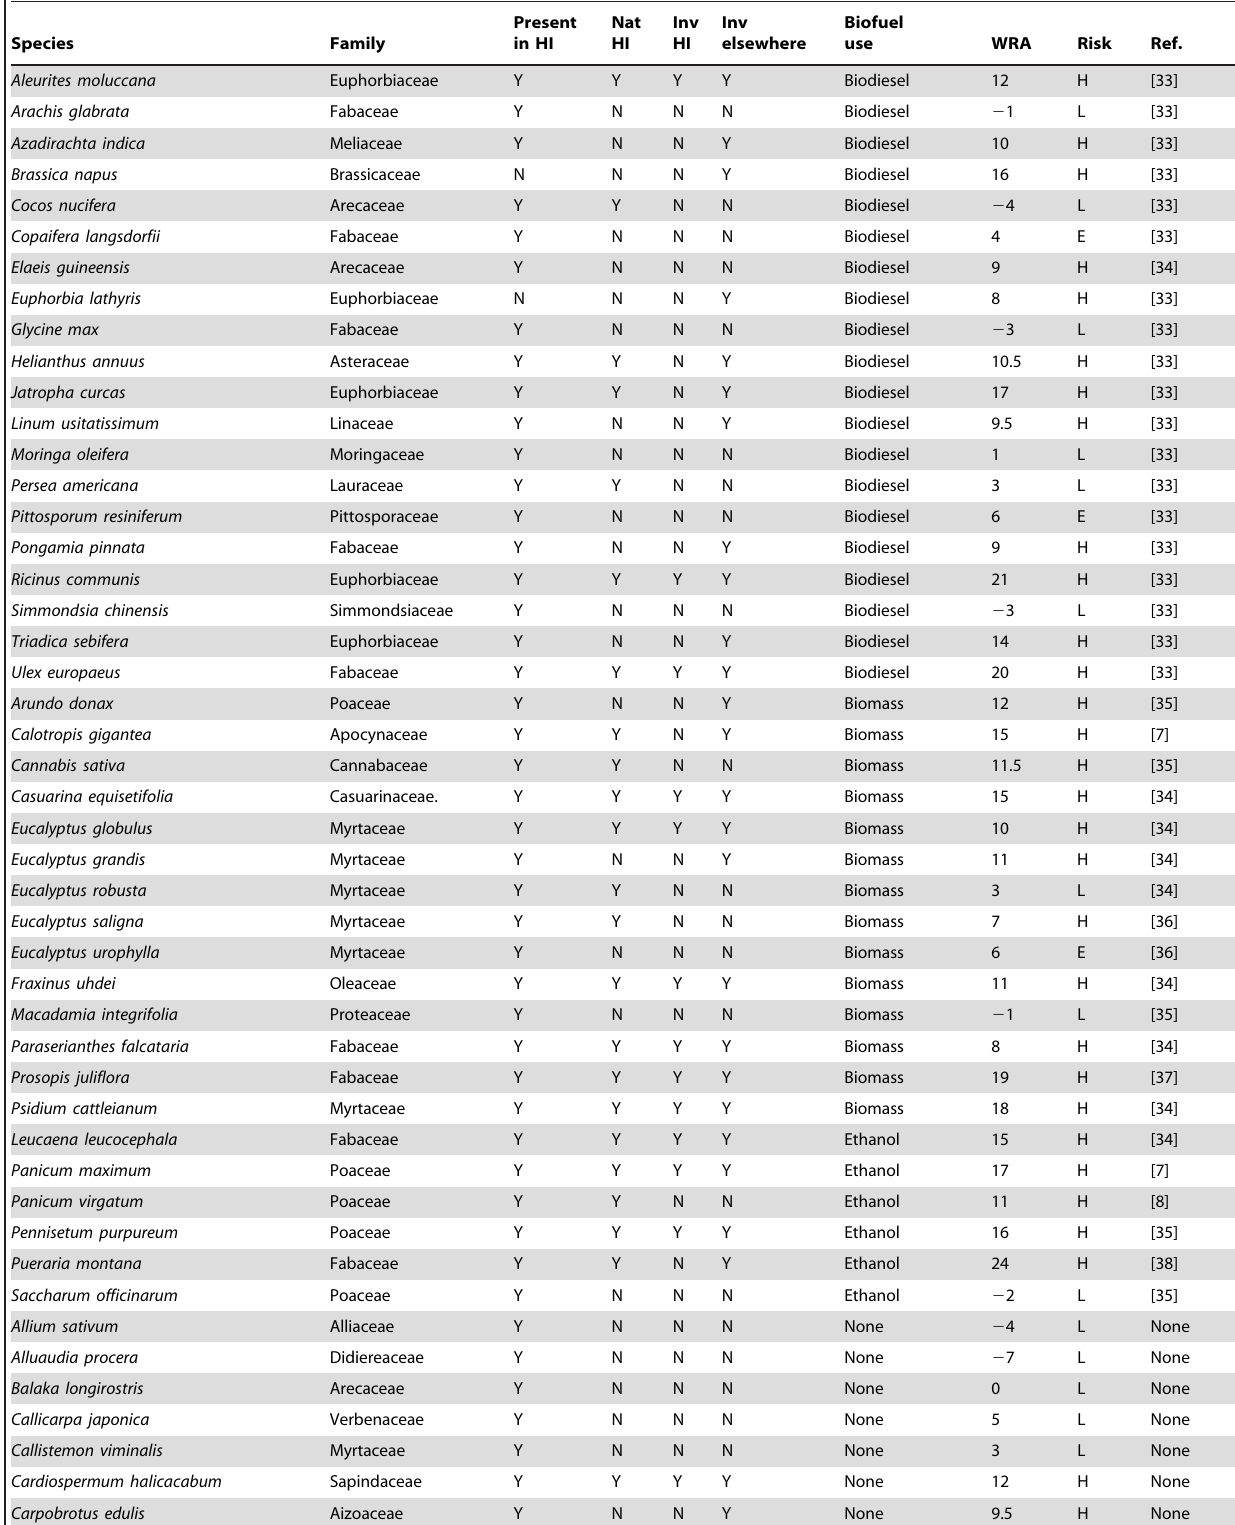
Table 3. List of biofuels (n=40) and introduced species (n=40) in the Hawaiian Islands (HI) analyzed in this study, with associated Weed Risk Assessment (WRA) scores, naturalization (Nat) or invasive (Inv) status, biofuel use and risk category (H =High, L=Low, E =Evaluate*, NA =Not